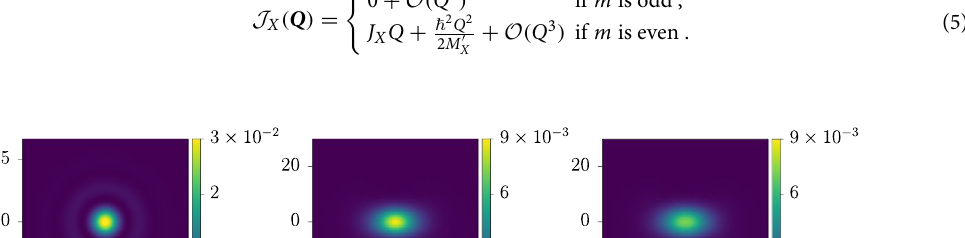
Figure 9. Relative real-space probability densities of the exciton eigenstates from top to bottom, to the first five solid- and dashed-line states of Fig. 4. More precisely, the states shown are 2 0 n , m (left column), | ; � ± ; m are indicated in each plot. We have set Q along the x -direction with Q